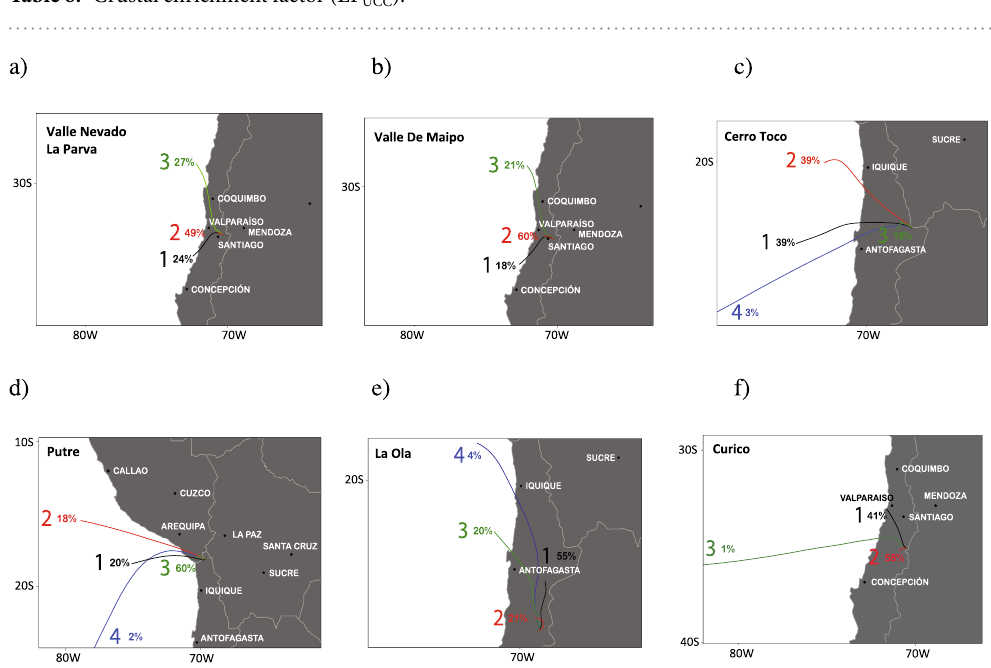
Figure 5. 36-h back trajectory clusters. ( a ) Valle Nevado/La Parva; ( b ) Valle del Maipo; ( c ) Cerro Toco; ( d ) Putre; ( e ) La Ola; ( f ) Curicó. Plots generated by the using MeteoInfo software tools for meteorological data visualization 63